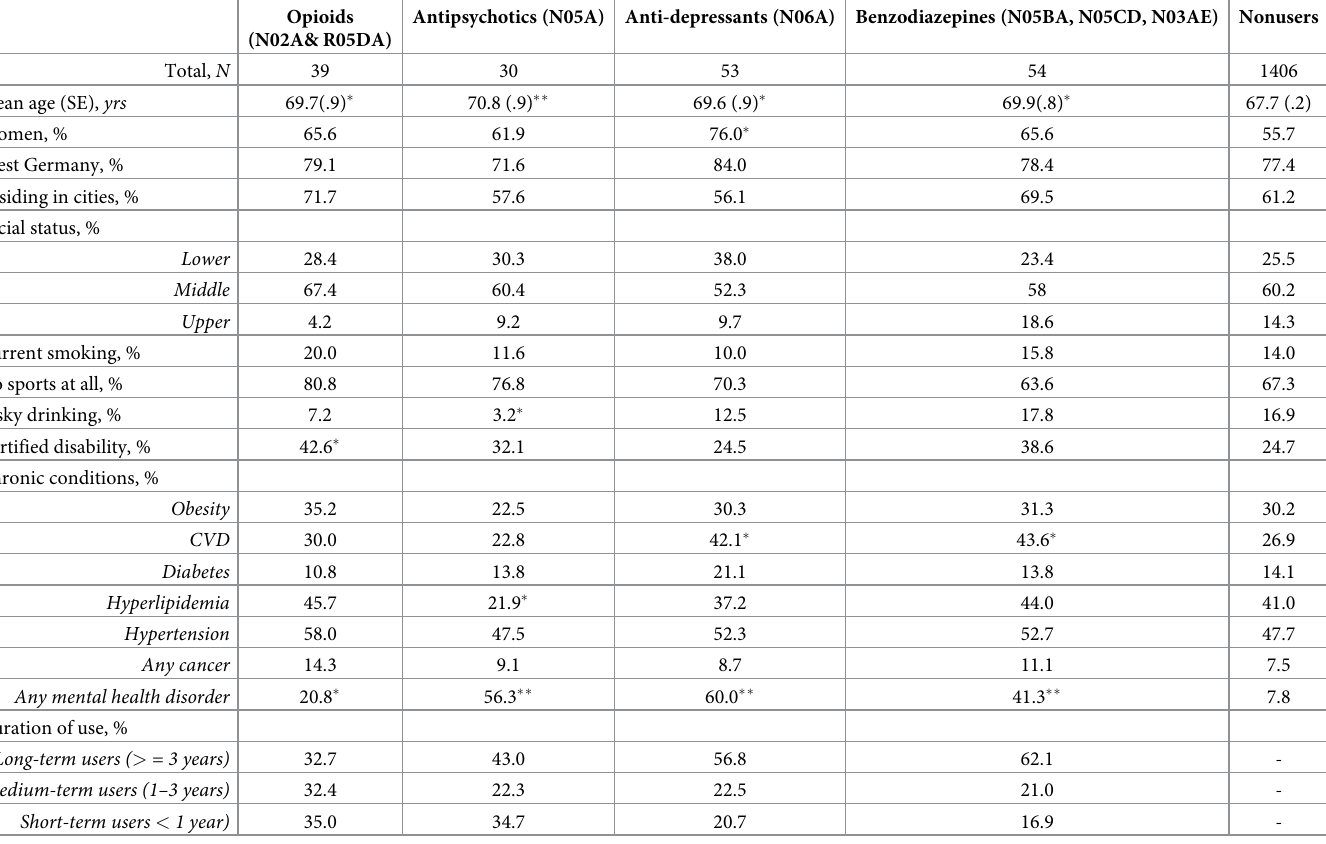
Table 1. Descriptive characteristics of study population at baseline. Comparison between psychotropic drug users and nonusers. GNHIES98 mortality follow-up